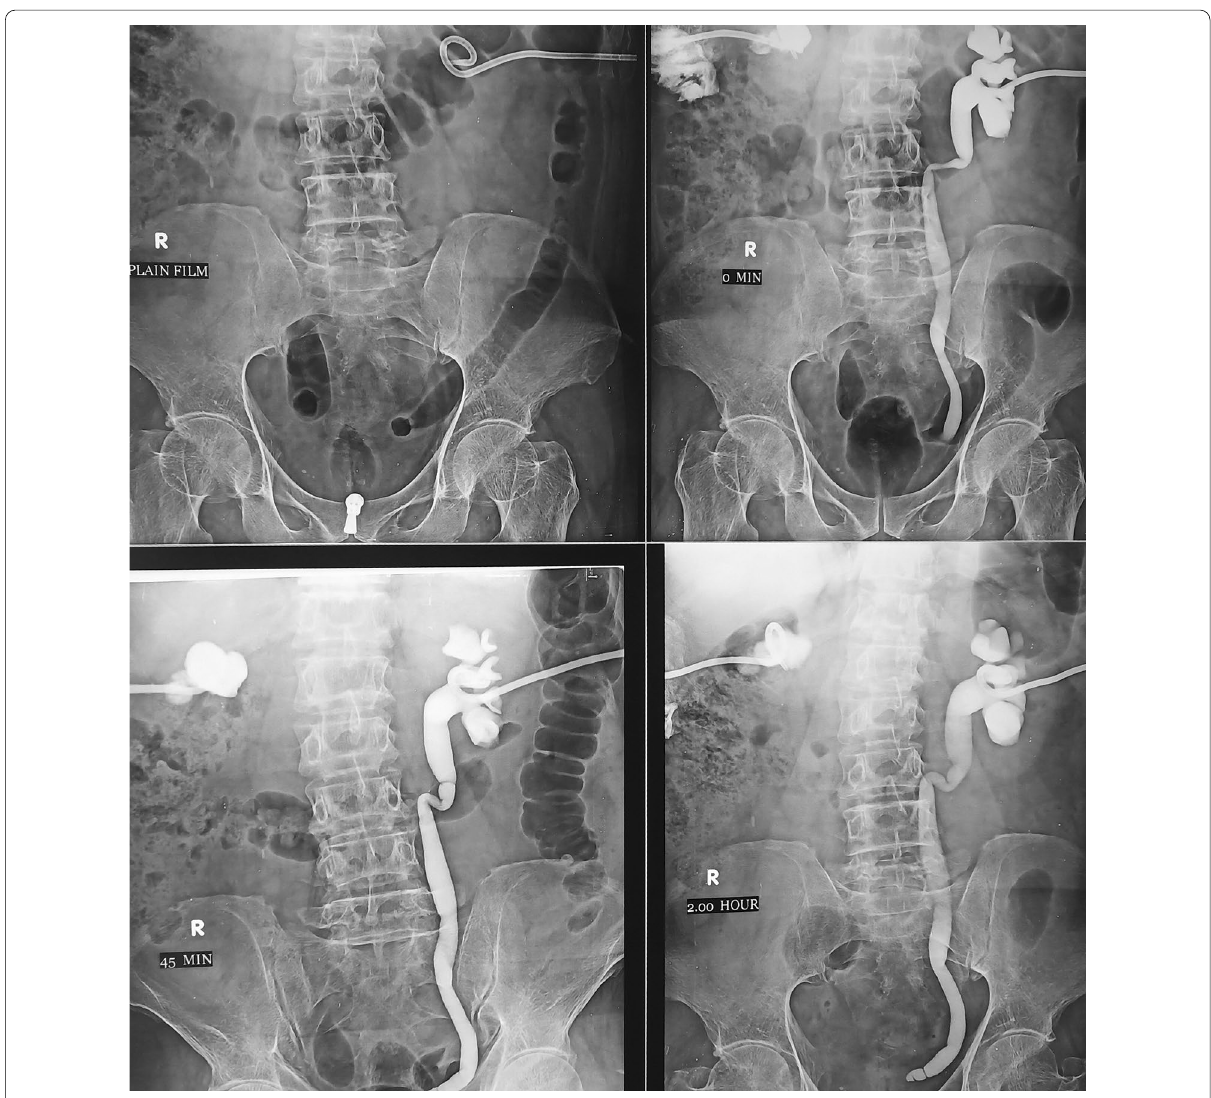
Fig. 4 Bilateral nephrostogram showing Rt pelvic junction obstruction and left vesicoureteric junction obstruction with no evidence of contrast in the bladder